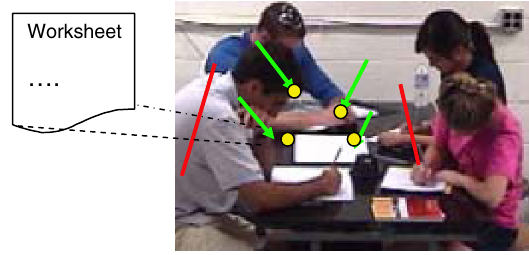
FIG. 3 (color online). Student behaviors oriented toward the